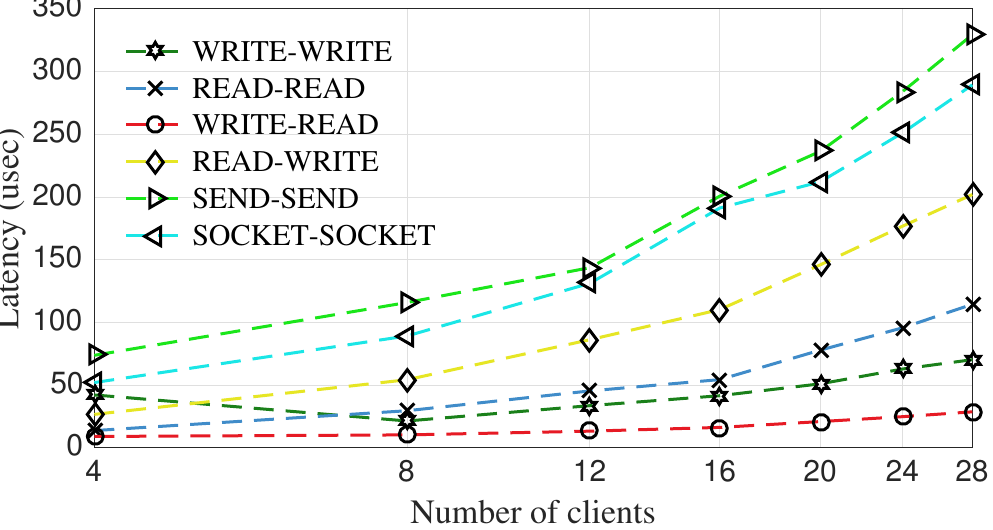
Figure 14. Latency of communication